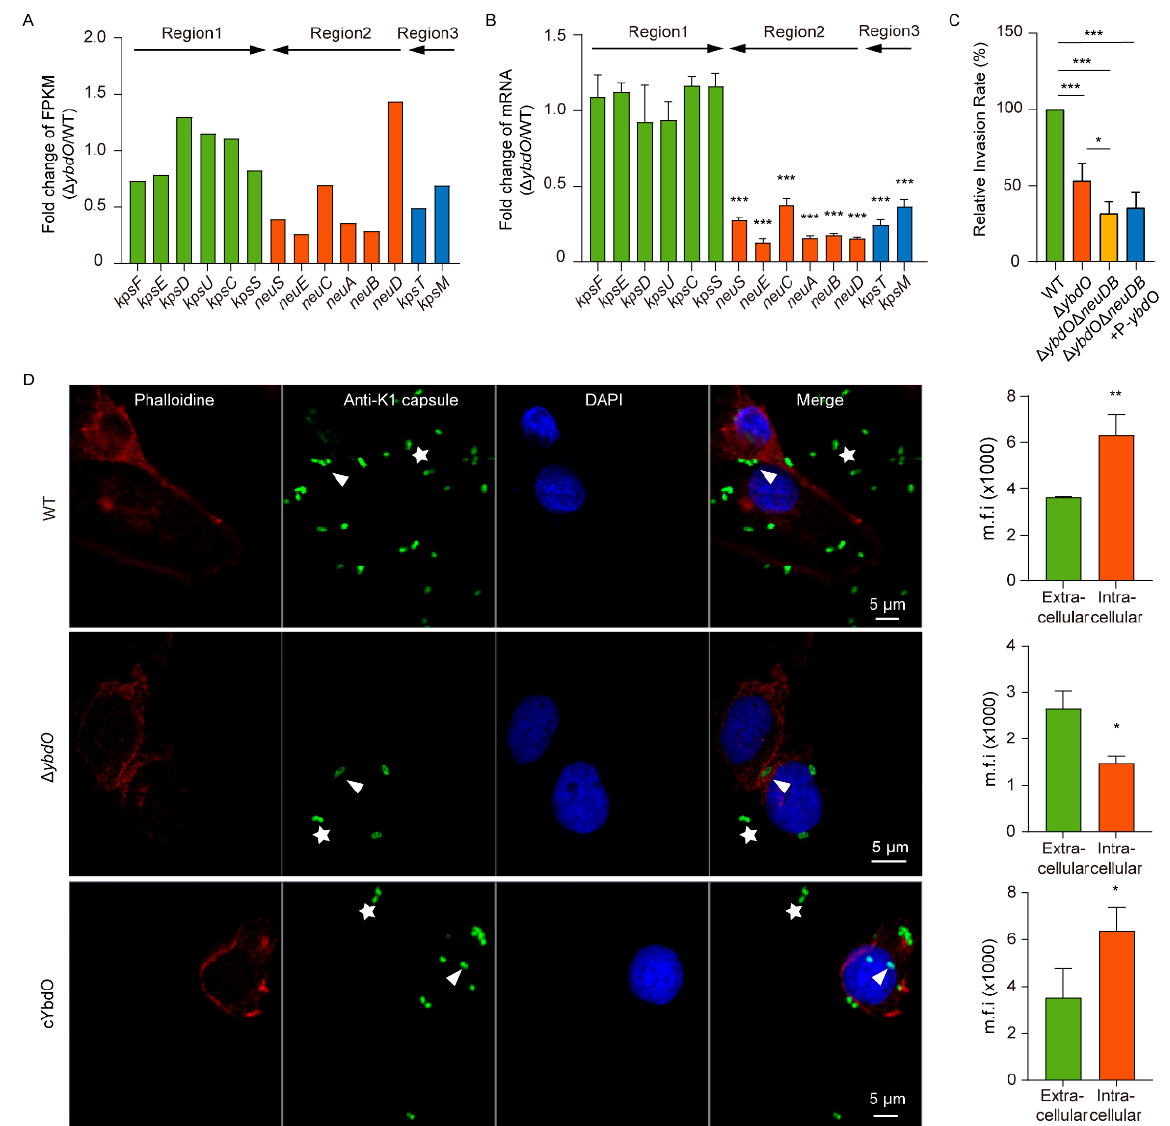
Figure 4. YbdO influences virulence by enhancing capsule production. ( A ) Altered transcription levels of K1 capsule genes following ybdO deletion. ( B ) Verification of the transcriptome data via qRT- PCR analysis of regions1, 2, and 3 in the K1 capsule. ( C ) Invasion rate of WT, ∆ ybdO , ∆ ybdO ∆ neuDB , and ∆ ybdO ∆ neuDB+P-ydbO E. coli K1 in HBMECs. The invasion abilities of the deletion strains were calculated relative to that of the WT strain. ( D ) Invasion by the WT, ∆ ybdO , and cybdO E. coli K1 strains according to immunofluorescence analysis of HBMECs. The actin cytoskeleton (red), K1 capsule (green), and nuclei (blue) are shown, intracellular bacteria are indicated by arrowheads, and extracellular bacteria are indicated by stars. Mean fluorescence intensity (m.f.i.) ± SD per bacterium per field in the intracellular (orange bars, n = 10) and extracellular samples (green bars, n = 10). ( B – D ) Data were obtained from three independent experiments and analyzed using Student’s t -test. * p < 0.05, ** p < 0.01, *** p < 0.001. Deletion of ybdO resulted in decreased expression of genes of regions 2 and 3, result- ing in a decreased E. coli K1-invasion rate. To further verify whether YbdO contributes to E. coli K1 invasion and virulence by activating K1 capsule gene expression, we con- structed a ybdO / neuDB double mutant strain ( ∆ ybdO ∆ neuDB ) and a complementary strain ( ∆ ybdO ∆ neuDB strain complemented with ybdO , ∆ ybdO ∆ neuDB+ P- ybdO ) and performed HBMEC-invasion assays. The rate of HBMEC invasion by ∆ ybdO ∆ neuDB (31.95%)